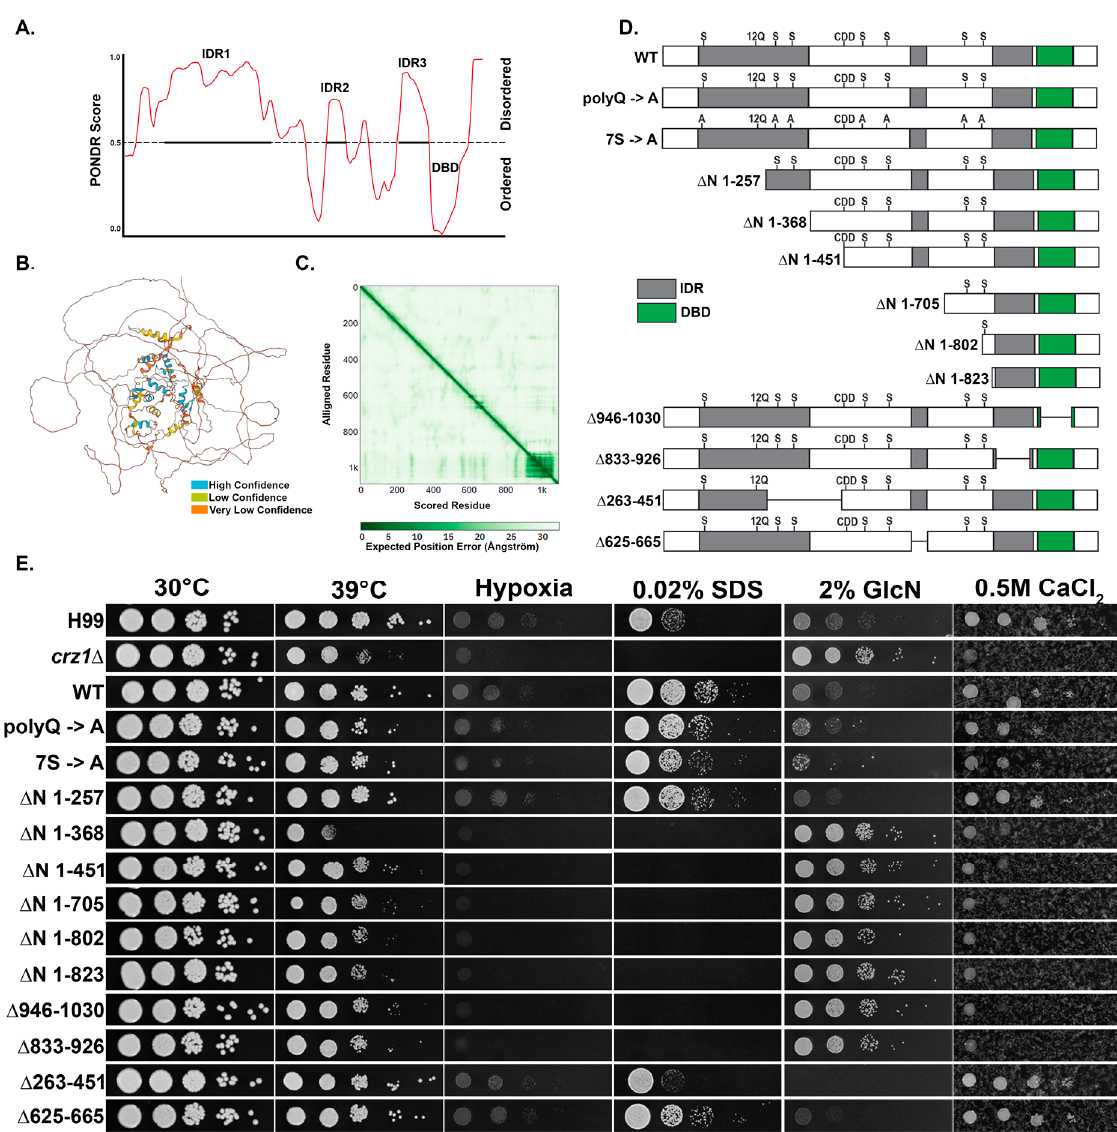
Figure 5. Mutational analysis of the Crz1 protein. ( A ) Results of PONDR (Predictor of Natural Disordered Regions) analysis of Crz1. A higher score correlates with higher disorder in the protein sequence. ( B ) AlphaFold prediction of Crz1 protein structure. The color pattern indicates the confidence level of the prediction. ( C ) The AlphaFold predicted aligned error plot shows dark green patches indicative of inter-protein interactions. ( D ) Protein diagrams of Crz1 mutant alleles used in this study. Green indicates the DNA binding domain (DBD) and grey indicates regions of intrinsic disorder (IDRs). The putative calcineurin-docking domain (CDD) [10], phosphorylation sites (S) [21], and polyQ region (12Q) are labeled. ( E ) The WT strain H99, the crz1 Δ mutant, and mutant alleles in the crz1 Δ mutant background were grown overnight in YPD, serially diluted, and spotted onto the media and incubated for two days as indicated.